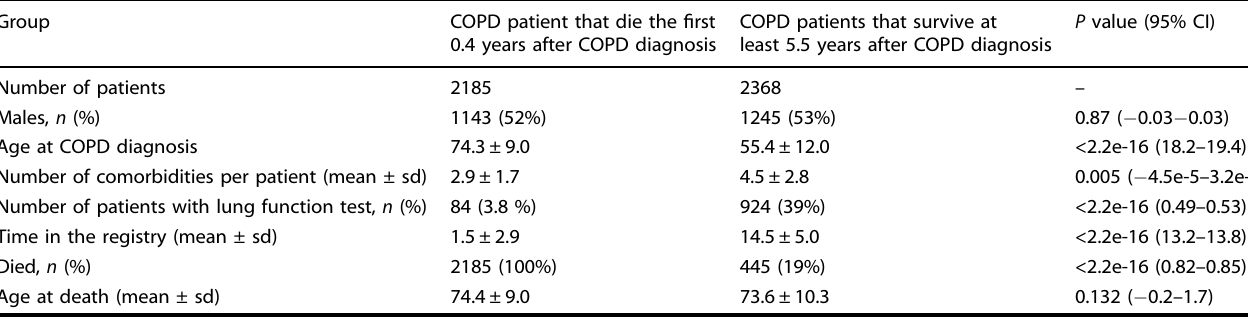
Table 2. Comparison of characteristics of groups of most dissimilar patients.